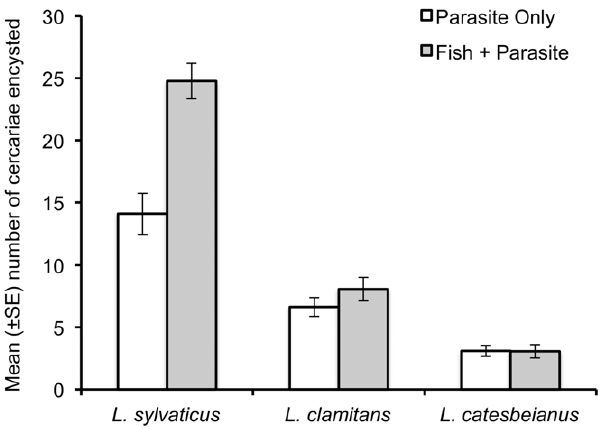
Figure 4. Mean ( ± SE) number of encysted metacercariae (out of a potential 36 cercariae) for all three species in the parasite only and ‘fish + parasite’ treatments. The species by fish presence interaction was significant (negative binomial GLM analysis of deviance, species by fish; deviance=206.90, P =0.047).